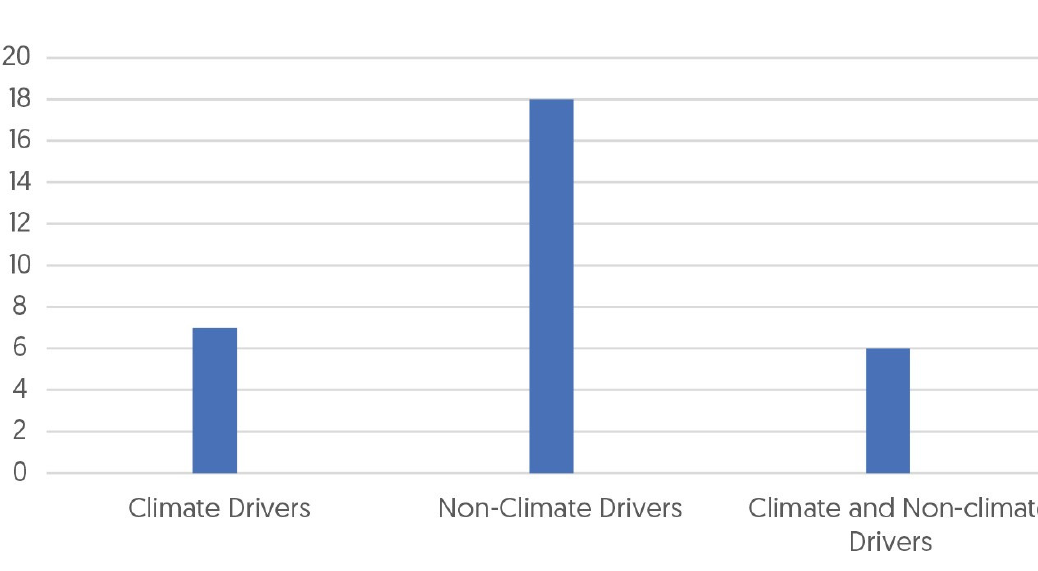
Figure A5. Drivers of land use change.